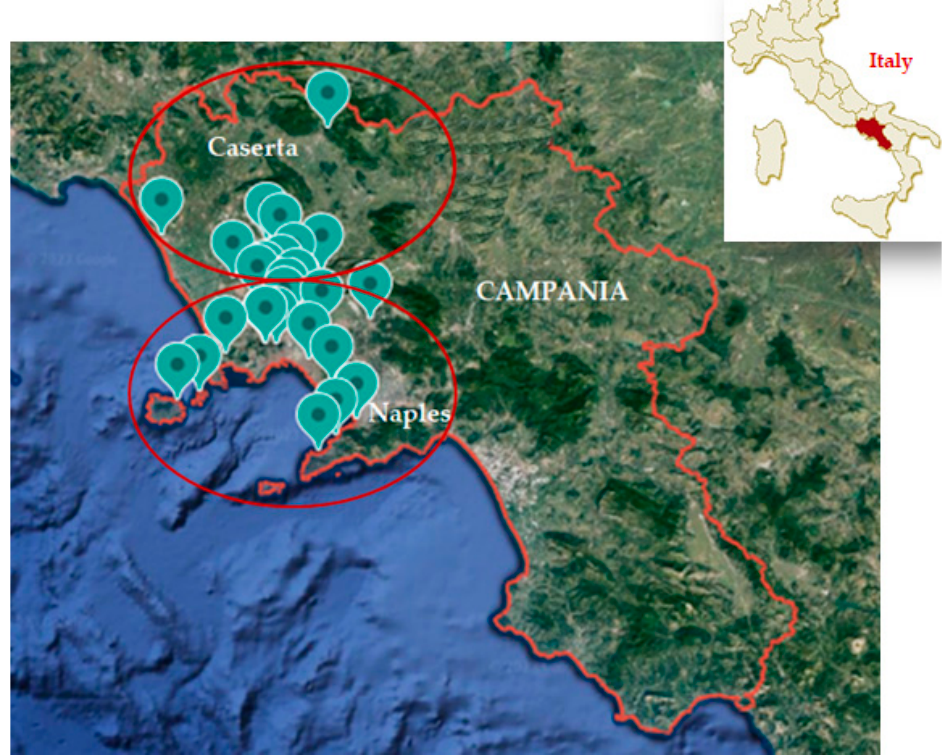
Figure 1. Study area